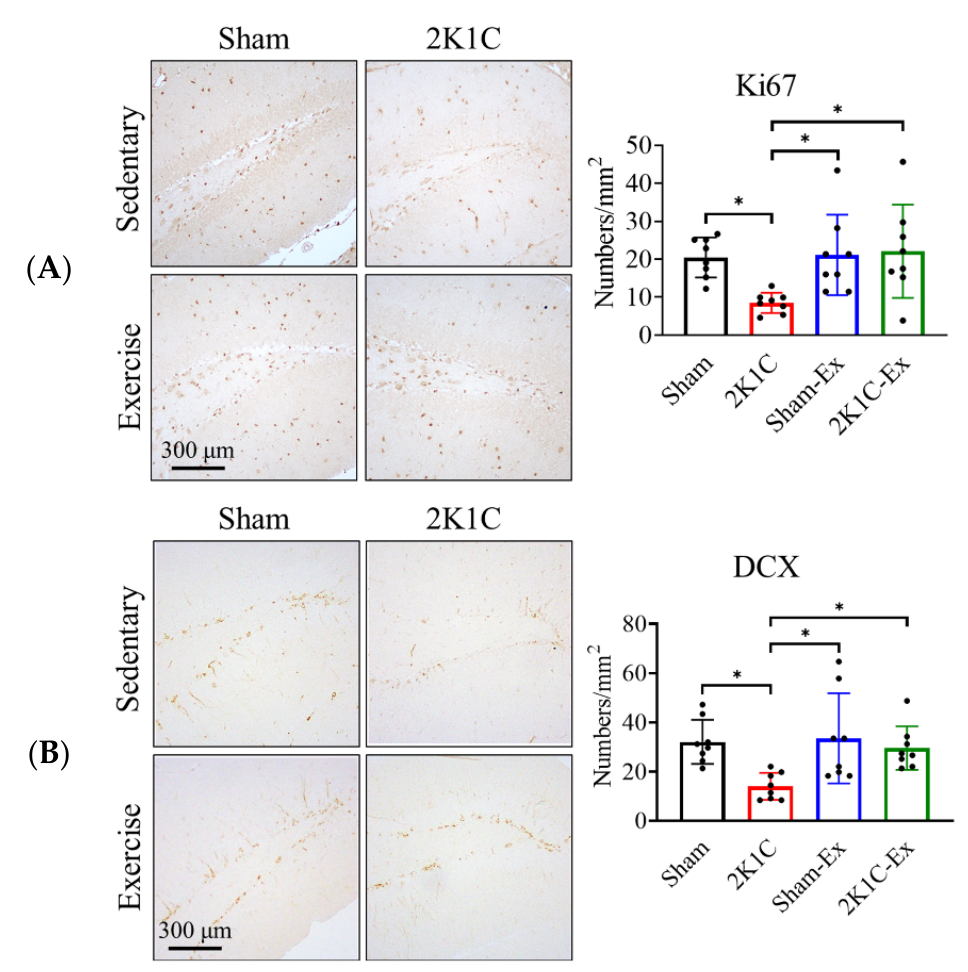
Figure 2. Exercise prevents the 2K1C-hypertension-induced AHN impairment. The immunohisto- chemistry micrographs for ( A ) Ki67 + neuronal stem cells and ( B ) DCX + neuronal progenitor cells. The averaged data and s.d. are plotted. The statistical analysis was performed by one-way ANOVA and Holm-Sidak’s multiple comparisons. The sample sizes are seven for each group. *: p < 0.05. Scale bar, 300 µ